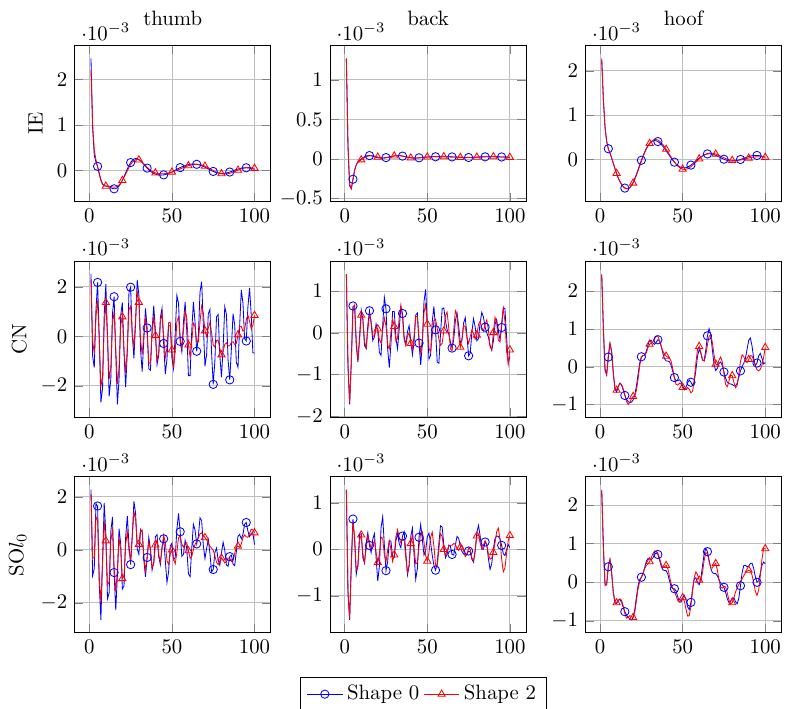
Figure 4. Visualisation of the feature descriptor at different points of the centaur shape, obtained through the solution of the wave equation using the IE solver with δ -peak initial conditions. Shape 0, Shape 2 and the point are equal to the points, and shapes are shown in Figure 1. ( Rows ) Different solver. ( Columns ) Different